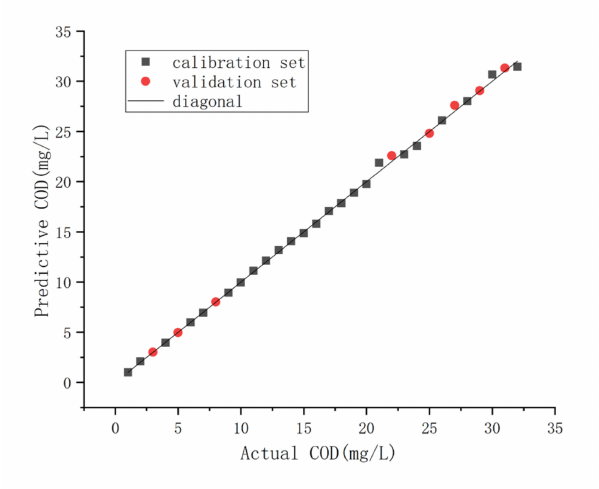
Figure 12. Fitting between predictive values and actual values in the calibration set and validation set in